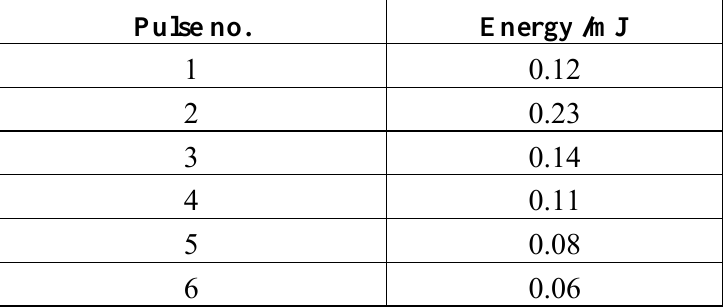
Table 2. Pulse energies of the ramped laser